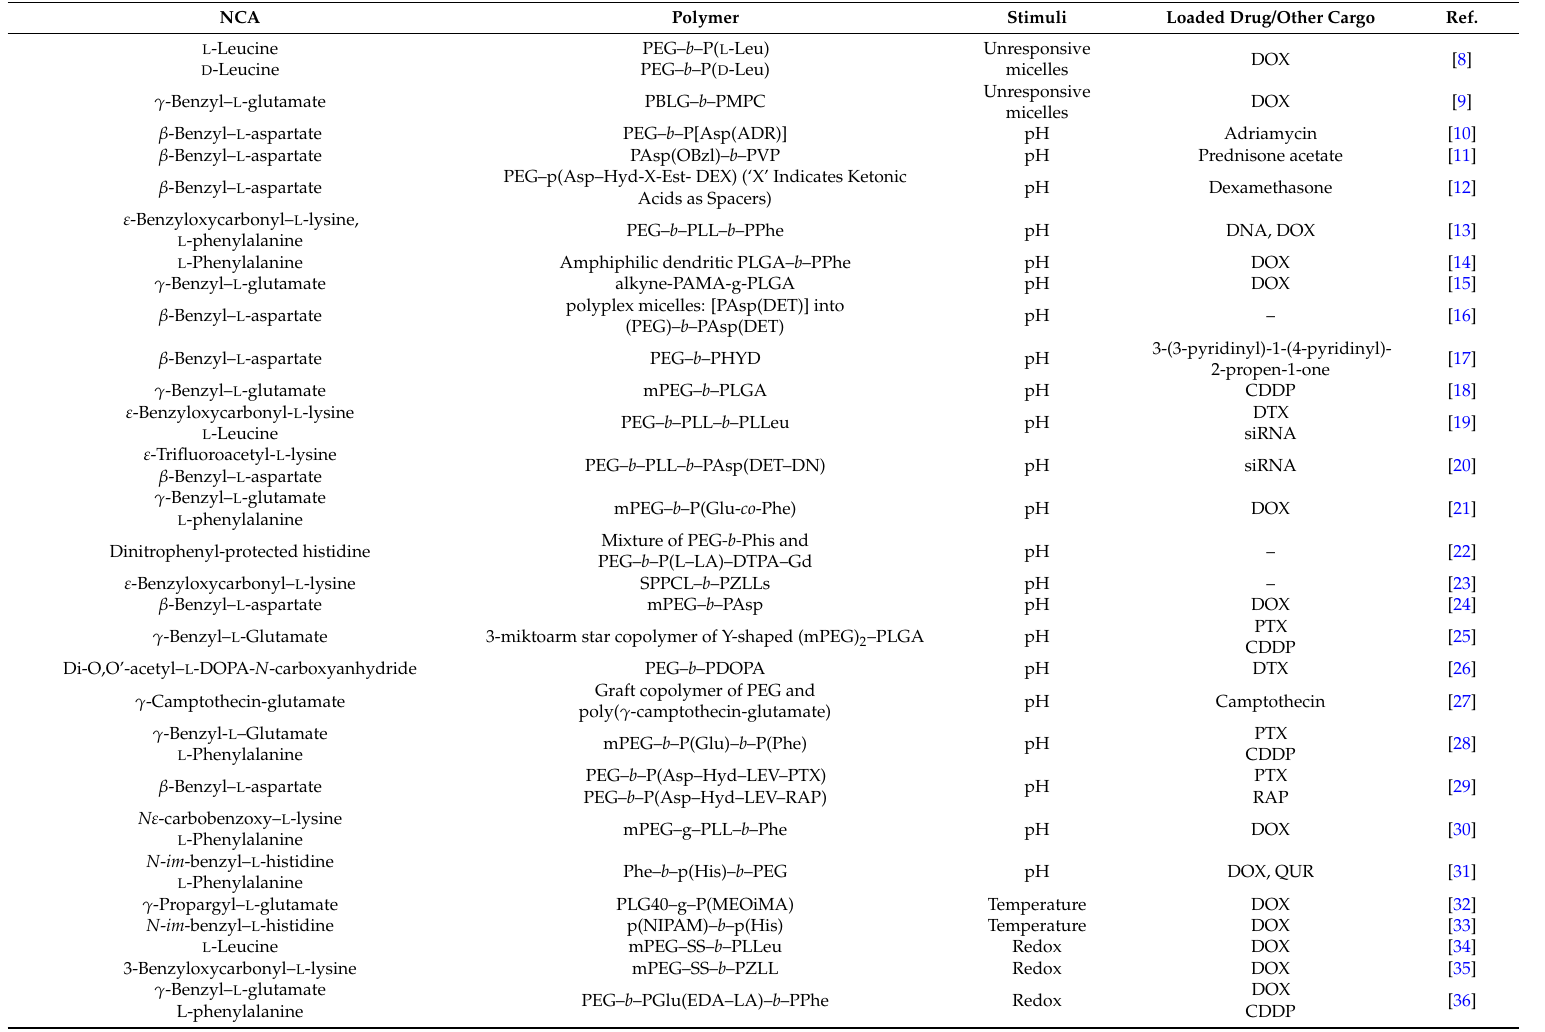
Table 1. Summary of the micelles formed by polypeptide containing polymers synthesized via N-carboxy anhydrides to treat cancer. It is related to all reviewed